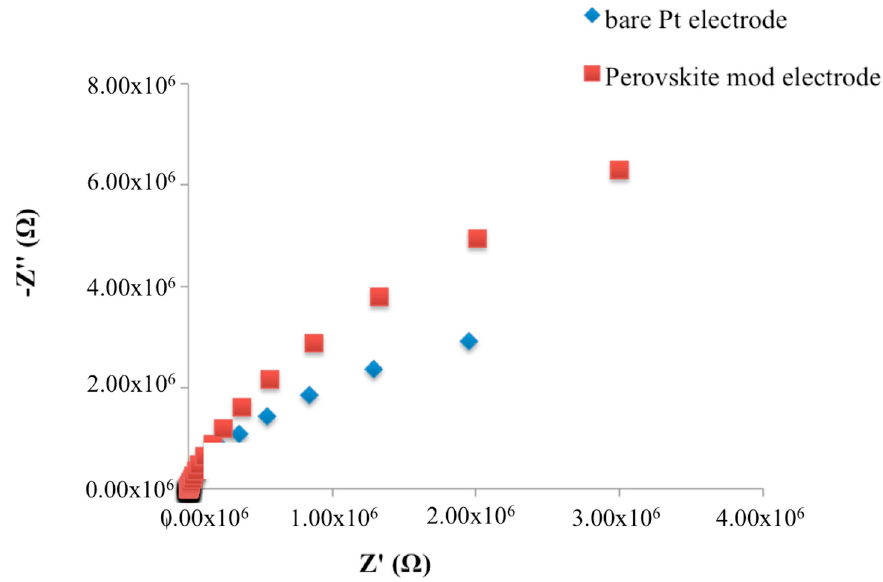
Figure 2. Nyquist plots in non-faradaic impedance measurements of bare and SrTiO 3 -modified Pt electrodes.